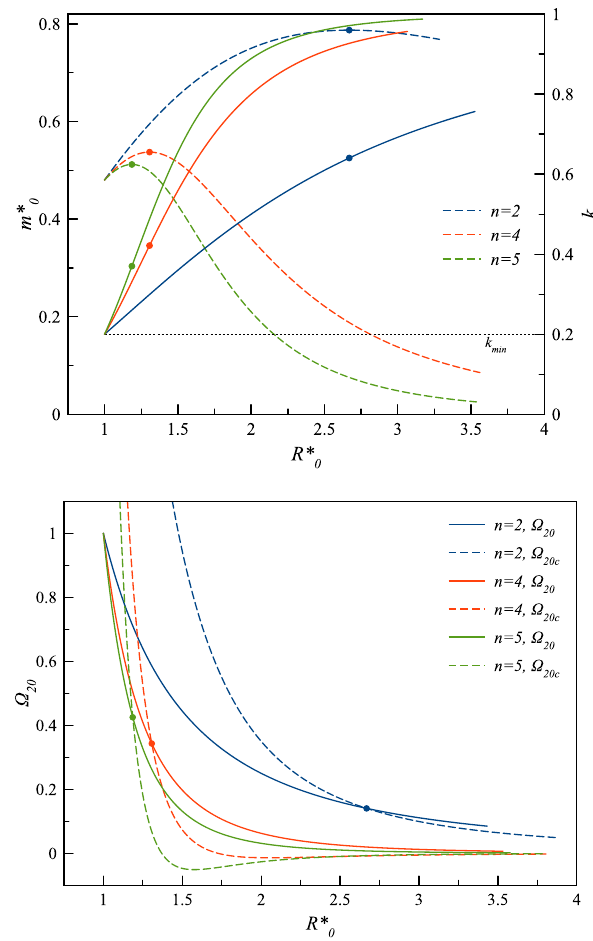
= m ∗ ( R ∗ ) (dashed line) 0 0 0 and Ω 20 , the value of 0